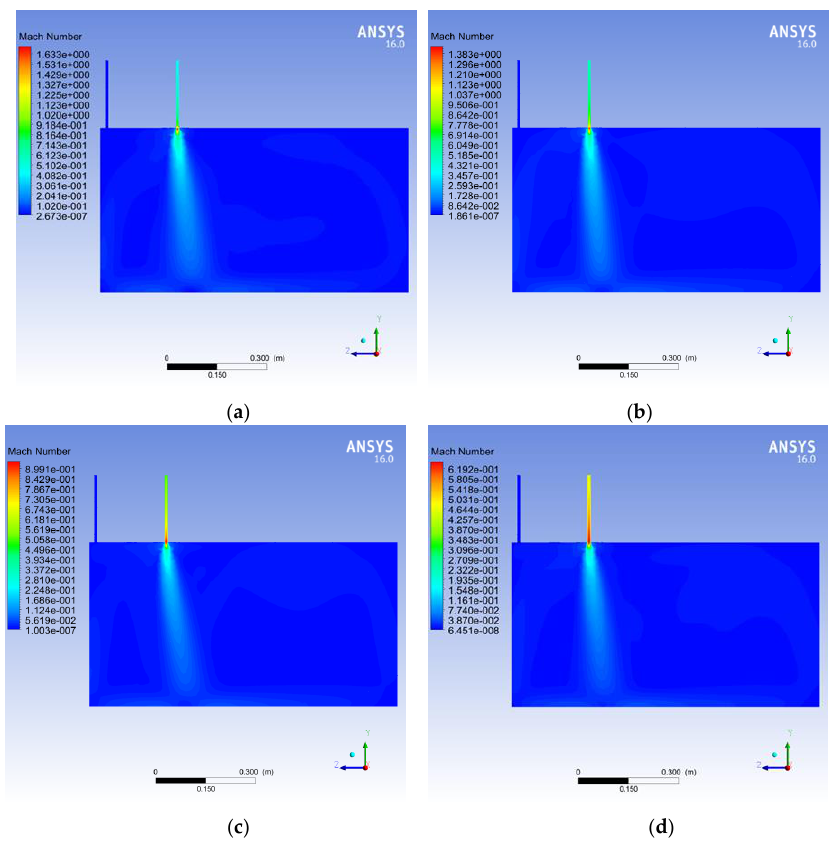
Figure 17. Air inlet with a flow rate of 27 L/min, valve C ( a ) Mach number after 1 s. ( b ) Mach number after 3 s. ( c ) Mach number after 6 s. ( d ) Mach number after 9 s.